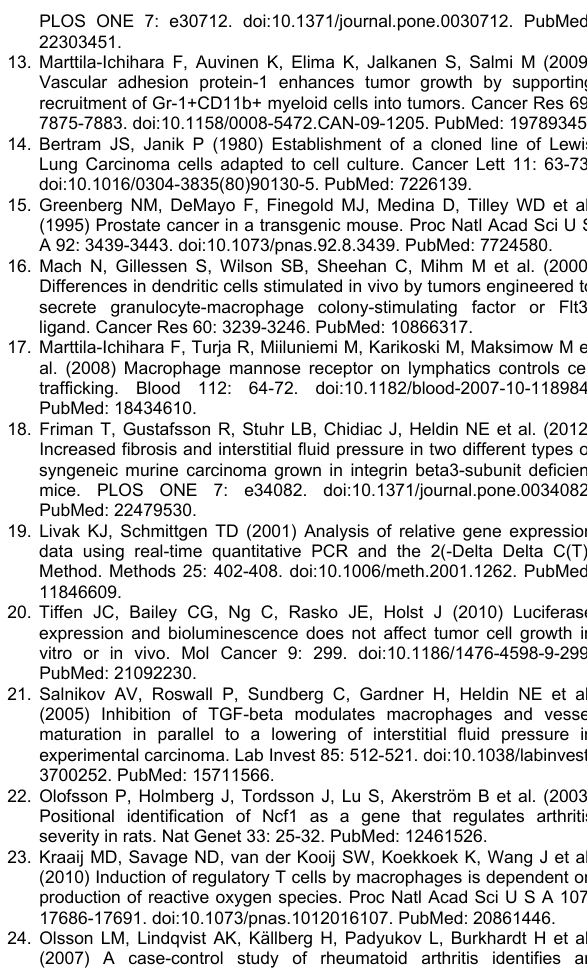
(2007) A case-control study of rheumatoid arthritis identifies an